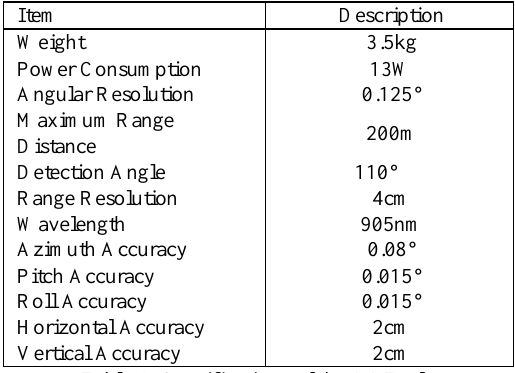
Table 1. Specifications of the AOEagle